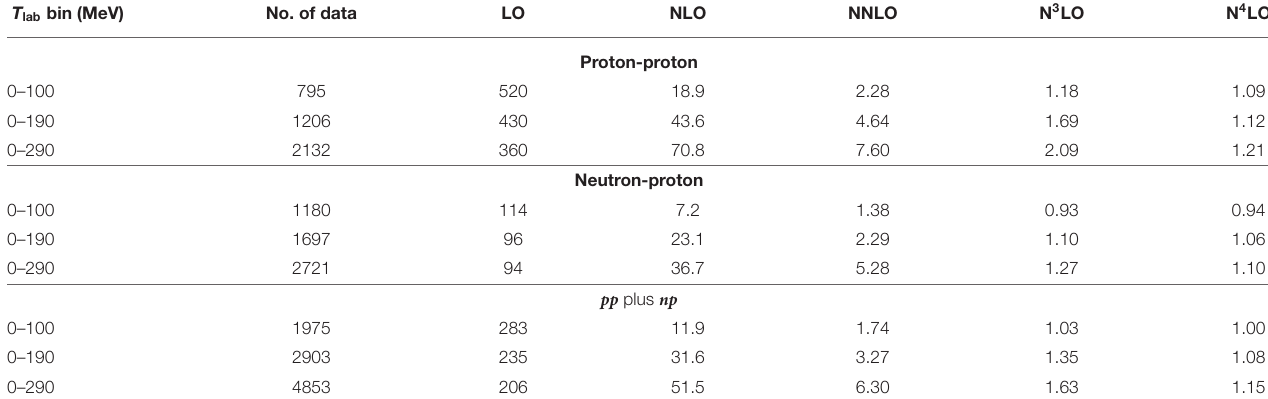
500 MeV in all cases). =